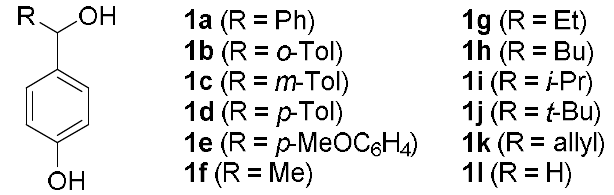
Figure 1. Phenol-ferrocene conjugates: ( a ) Ferrocifen family; ( b ) ferrocene bisphenol derivatives; ( c ) ortho -substituted ferrocenyl phenols previously developed in our group; ( d ) para -substituted ferrocenyl phenols reported in this study. Figure 2. Starting p -hydroxybenzyl alcohols 1 used in this work.